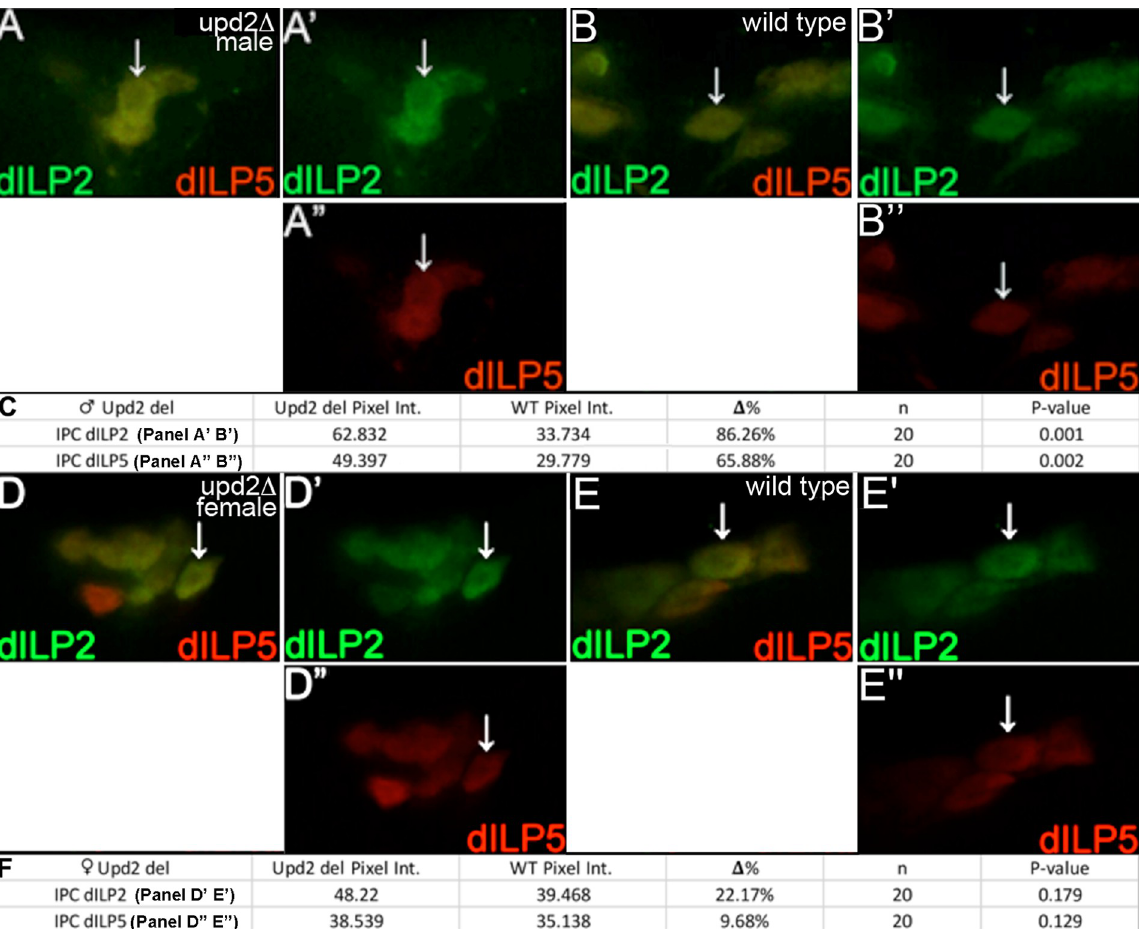
Fig 5. upd2 mutant unmated adult female IPCs do not phenocopy dSmad2 mutants. Brains from unmated adult males and females as shown in Fig 2. A-C) One day old unmated adult male brains with IPCs labeled for dILP2 (green) and dILP5 (red). Each panel group shows two colors on the left and each single channel on the right. White arrows indicate IPCs analyzed for pixel intensity. A,A”) upd2 mutant male IPCs. B,B”) Wild type male IPCs. upd2 mutant male IPCs display significantly increased dILP2 and dILP5 pixel intensity compared to wild type males. C) Table as described in Fig 2 summarizing upd2 unmated mutant male pixel intensity comparisons in IPCs. D-F) One day old unmated adult female brains with IPCs labeled as above. D-D”) upd 2 mutant female IPCs. E-E”) Wild type female IPCs. upd2 mutant female IPCs display wild type dILP2 and dILP5 expression. F) Table as described in Fig 2 summarizing upd2 mutant female pixel intensity comparisons in